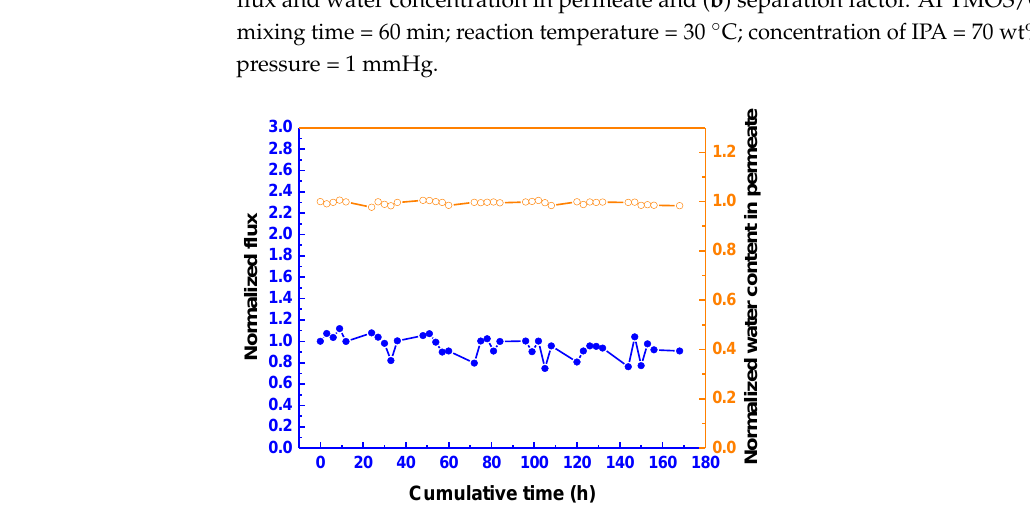
Figure 11. Membrane performance for a period of 168 h. APTMOS/CHDA ratio = 0.15; mixing time = 60 min; reaction temperature = 30 ◦ C; concentration of IPA = 70 wt%; downstream pressure = 1 mmHg; and operating temperature = 25 ◦ C. Table 2. Comparison of data on performance of various pervaporation membranes for dehydrating isopropanol